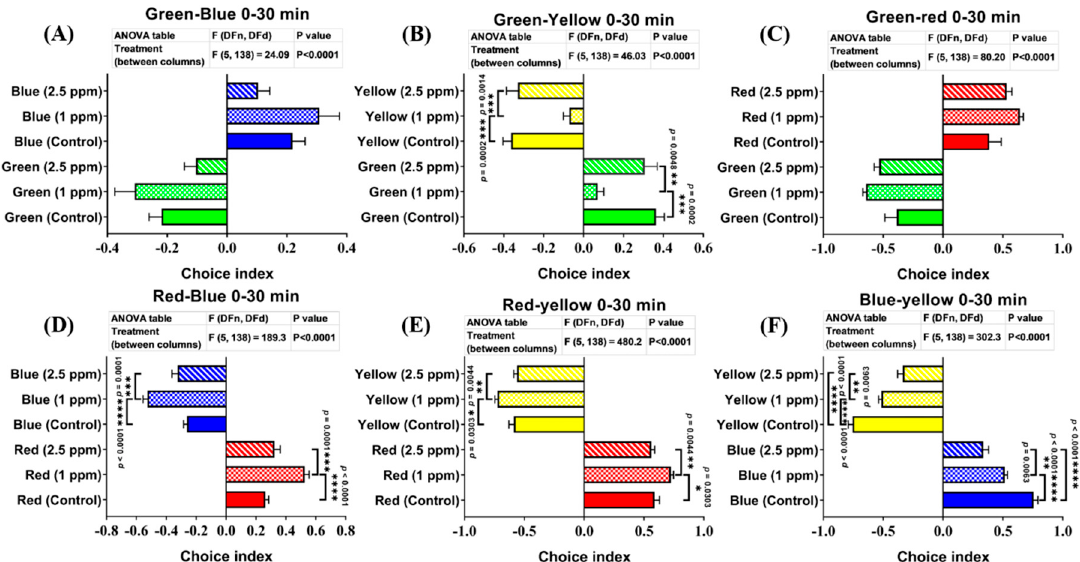
Figure 7. Comparison of the color preference behavior between control and donepezil-exposed fish after 17 days of donepezil exposure. The combinations of four colors were: ( A ) the green / blue test, ( B ) green / yellow test, ( C ) green / red test, ( D ) red / blue test, ( E ) red / yellow test, and ( F ) blue / yellow test. The data are expressed as the mean ± SEM values and were analyzed by two-way ANOVA ( n = 24; * p < 0.05, ** p < 0.01, *** p < 0.001, and **** p < 0.0001).